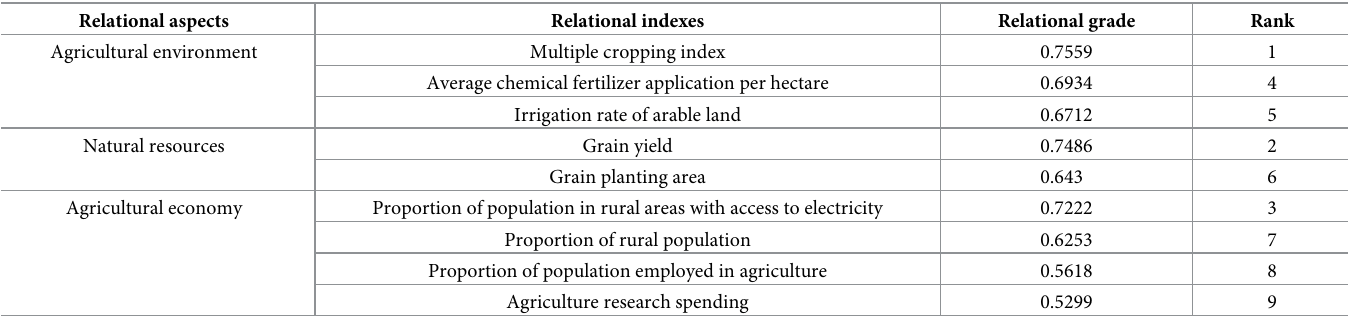
Table 4. Grey relational analysis results of grain production in Bangladesh.